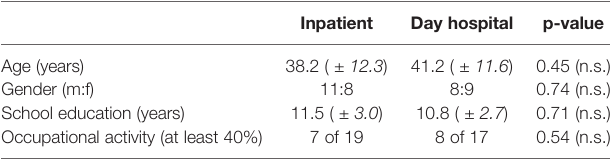
TABLE 2 | Age and school education in years, mean (± standard deviation) , p-values (t-tests, inpatient versus day hospital); gender (male/female), and occupational activity, p-values (Chi-square-tests, inpatient versus day